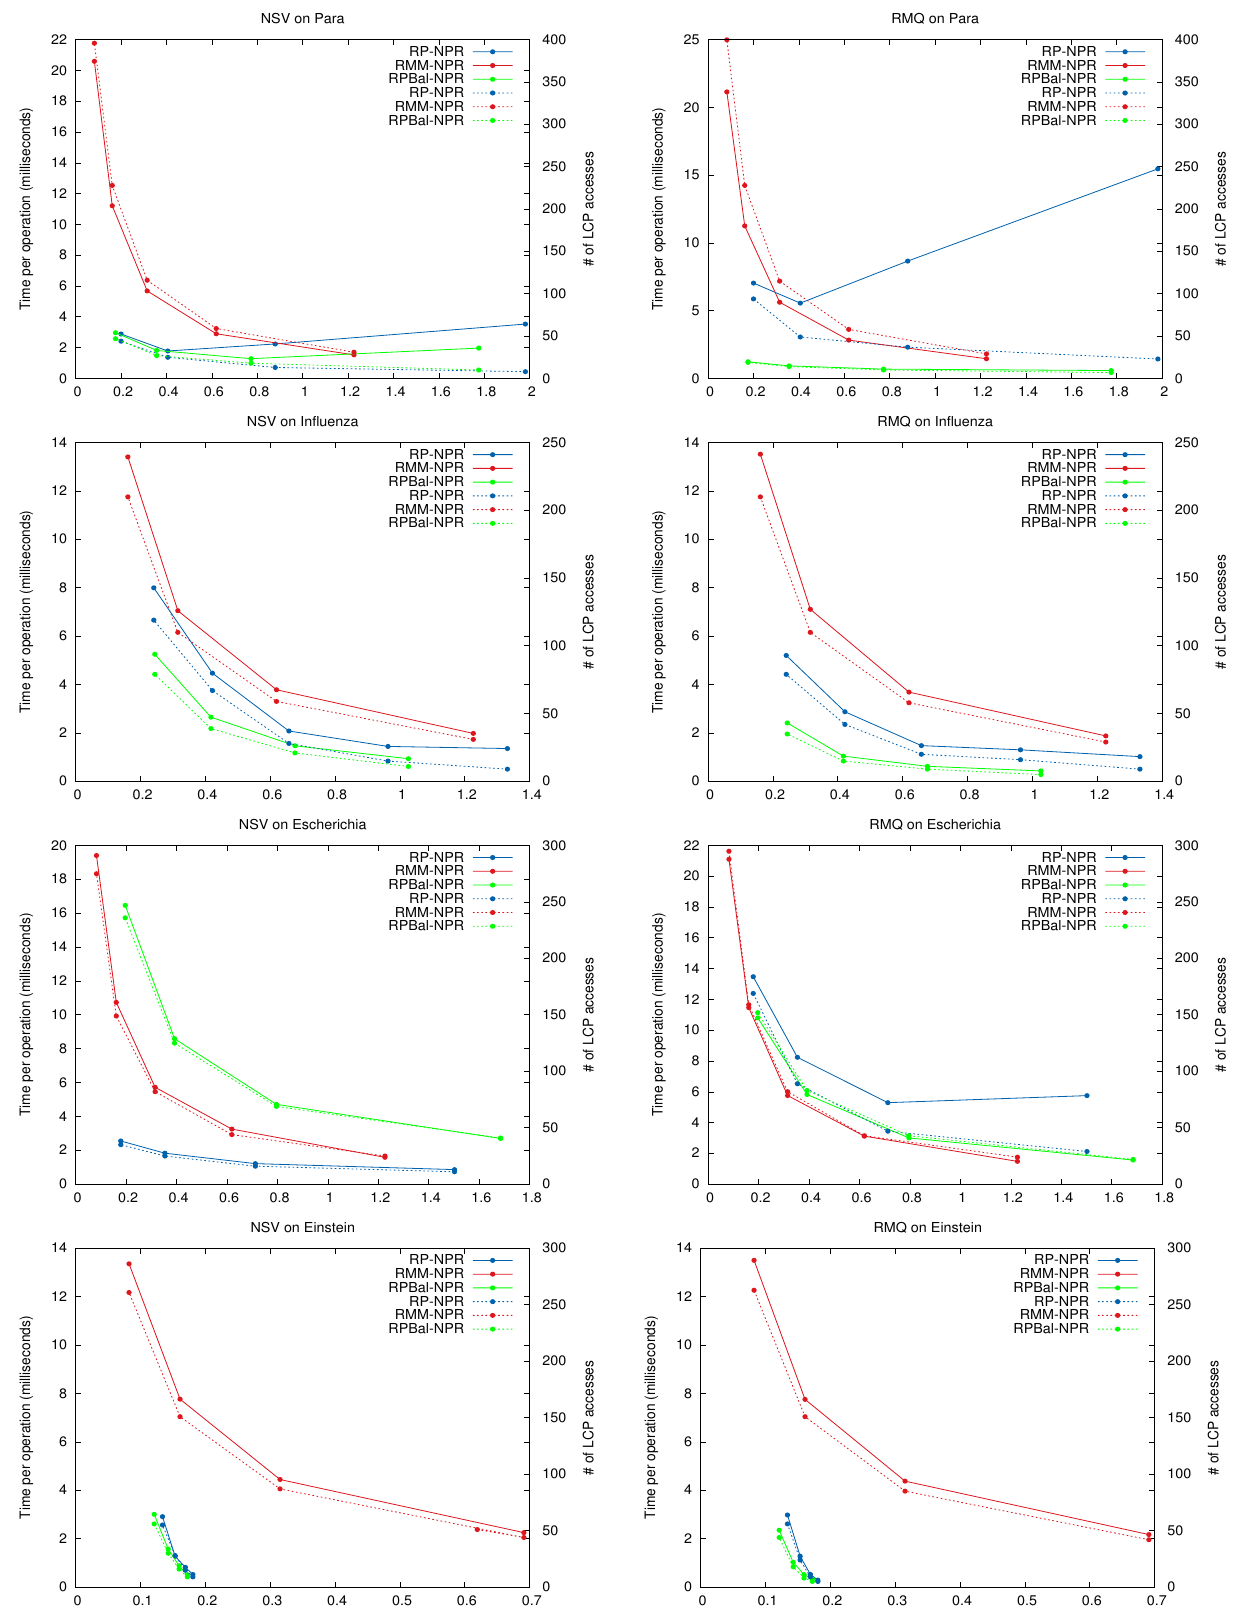
Figure 11. Space/Time performance of NPR operations. The x -axis shows the size of the NPR structure. On the left y -axis the average time per operation (solid lines), and on the right y -axis the average number of LCP accesses per operation (dashed lines). Note the log scale on y for Einstein